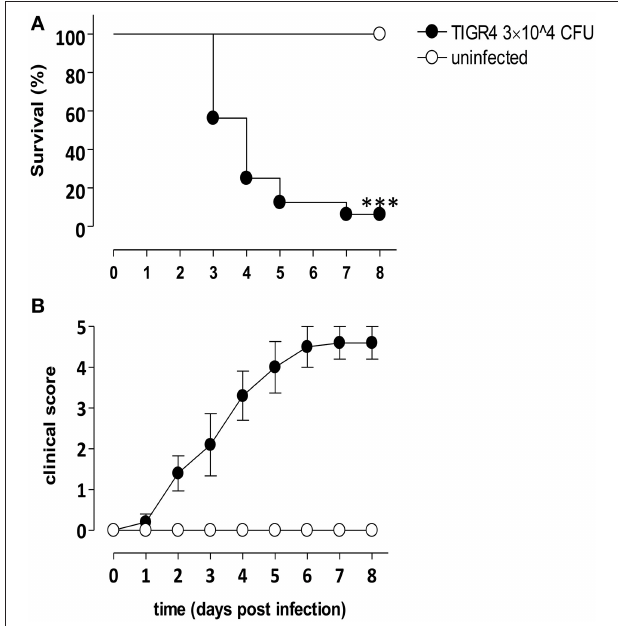
FIGURE 1 | Murine model of meningitis by S. pneumoniae. C57BL/6J mice were infected by the intracranial route with 3 × 10 4 CFU of S. pneumoniae strain TIGR4 (filled circles) or injected with bacterial growth medium (control, open circles). Data are from two independent experiments with 8 mice/group, and animals were monitored up to 8 days post infection. (A) Kaplan-Meier curve of mouse survival. Results were expressed as percentage of survival over time, and statistical differences were evaluated between infected mice and control group using Log-Rank test. Asterisks indicate statistical significance ( *** P < 0.0001 ). (B) Clinical score analysis was evaluated using a scale for severity of disease, from 0 (normal) to 5 (moribund), and values were reported as mean value ±